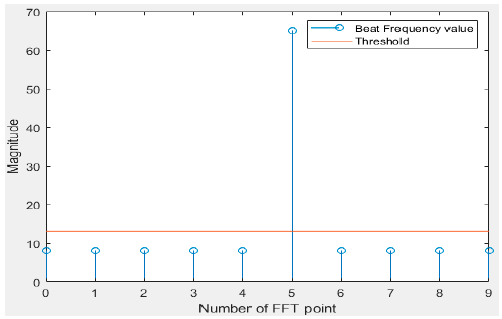
Figure 5. Example when the main lobe of beat frequency is located an integral multiple of the FFT bin.